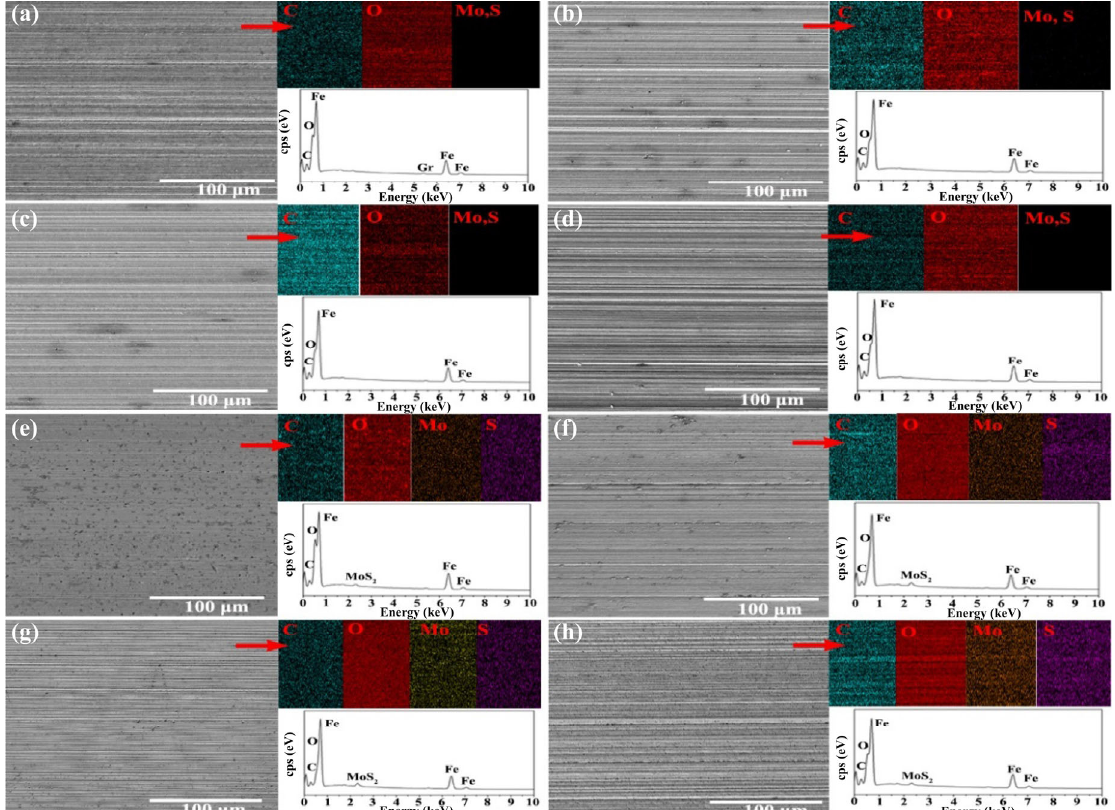
Fig. 8 Magnified SEM images of the worn surfaces lubricated with (a) PAG base oil, and PAG containing (b) 1 wt% CNT, (c) 1 wt% Gr, (d) 1 wt% C60, (e) 1 wt% MoS 2 , (f) 1 wt% MoS 2 @CNT, (g) 1 wt% MoS 2 @Gr, and (h) 1 wt% MoS 2 @C60 at 100 °C (SRV conditions: load, 100 N; stroke, 1 mm; frequency, 25 Hz; and duration, 30 min). The corresponding EDS spectra and element mapping are also shown in